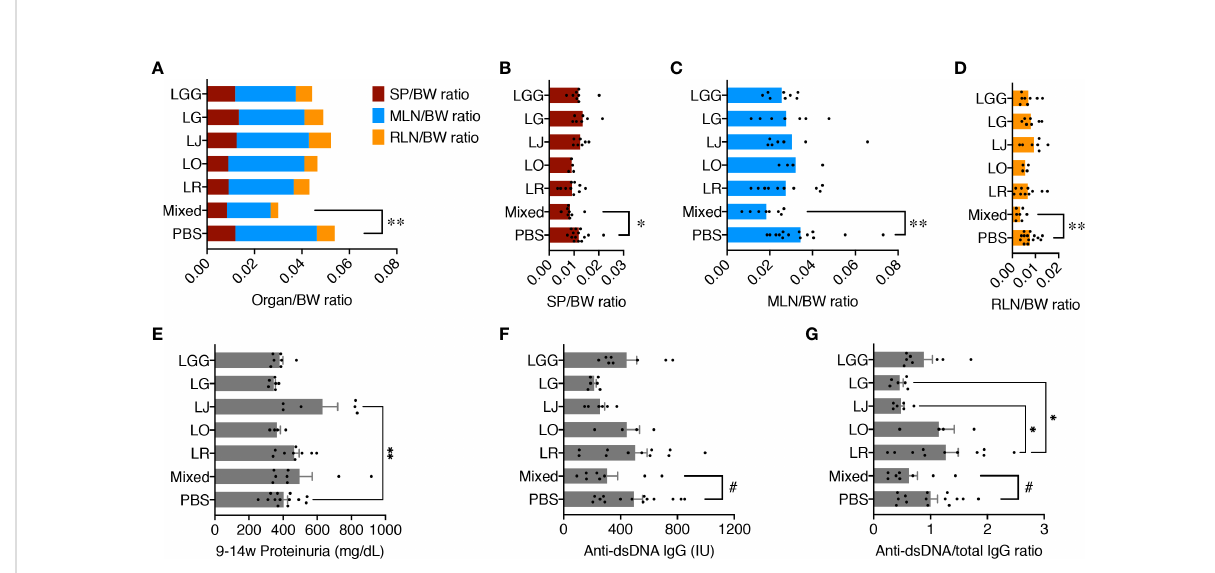
FIGURE 1 Five Lactobacillus species act synergistically to attenuate splenomegaly and lymphadenopathy. Female MRL/ lpr mice were treated with indicated Lactobacillus spp. at 10 9 total CFU/mouse twice a week from 3 weeks to 15 weeks of age. PBS, phosphate buffered saline control. Mixed, the mix of all 5 species. LR, LO, LJ, LG and LGG represent L. reuteri , oris , johnsonii , gasseri and rhamnosus , respectively. (A) Combined organ weight-to-body weight ratio. SP, spleen; MLN, mesenteric lymph node; RLN, renal lymph node. (B) SP-to-body weight ratio. (C) MLN-to-body weight ratio. (D) RLN-to-body weight ratio. (E) Accumulated proteinuria level from 9 weeks to 14 weeks of age. (F) Serum level of anti-dsDNA IgG at 15 weeks of age. IU, international units. (G) Serum level of anti-dsDNA IgG-to-total IgG weight ratio at 15 weeks of age. n ≥ 7 mice per group. Statistical signi fi cance (* p <0.05, ** p <0.01) is shown based on one-way ANOVA. Nearly signi fi cant differences between PBS and Mixed are shown as # p